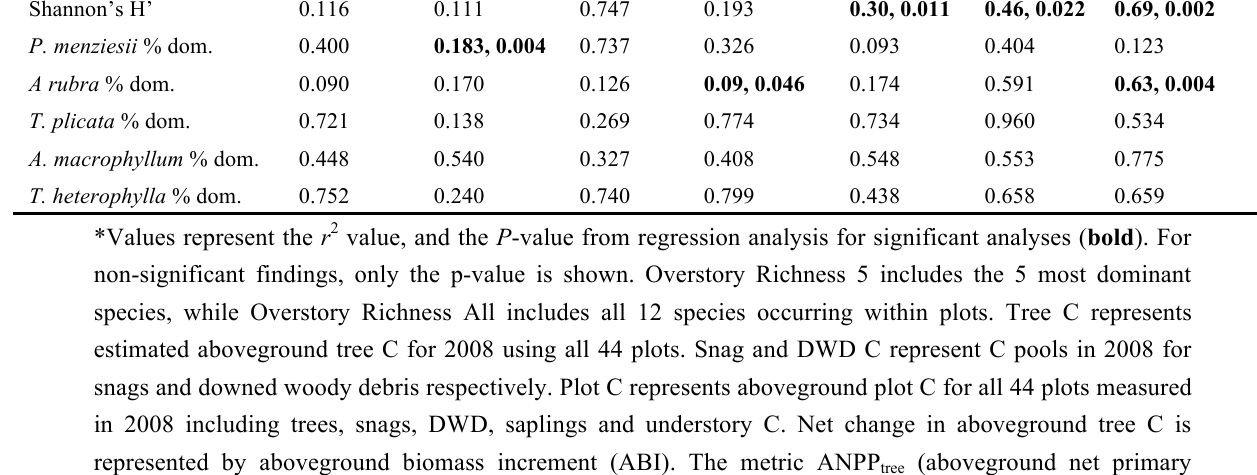
Table 2. Regression coefficient and significance results for regression analyses of plot carbon flux and pool estimates versus diversity metrics *. Tree C Overstory Richness 5 0.18, 0.004